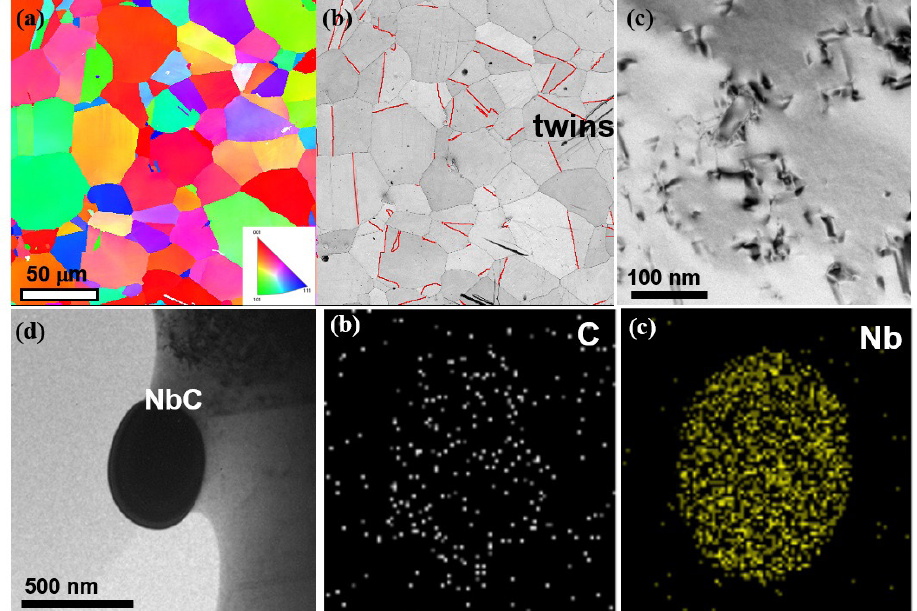
Figure 1. Solution treated sample of TP347H steel. (a) Inverse Pole Figure (IPF) map, (b) Twins remarked by red lines; (c) TEM image; (d) a NbC particle and EDS mapping; (e)-(f) C and Nb mapping, respectively.